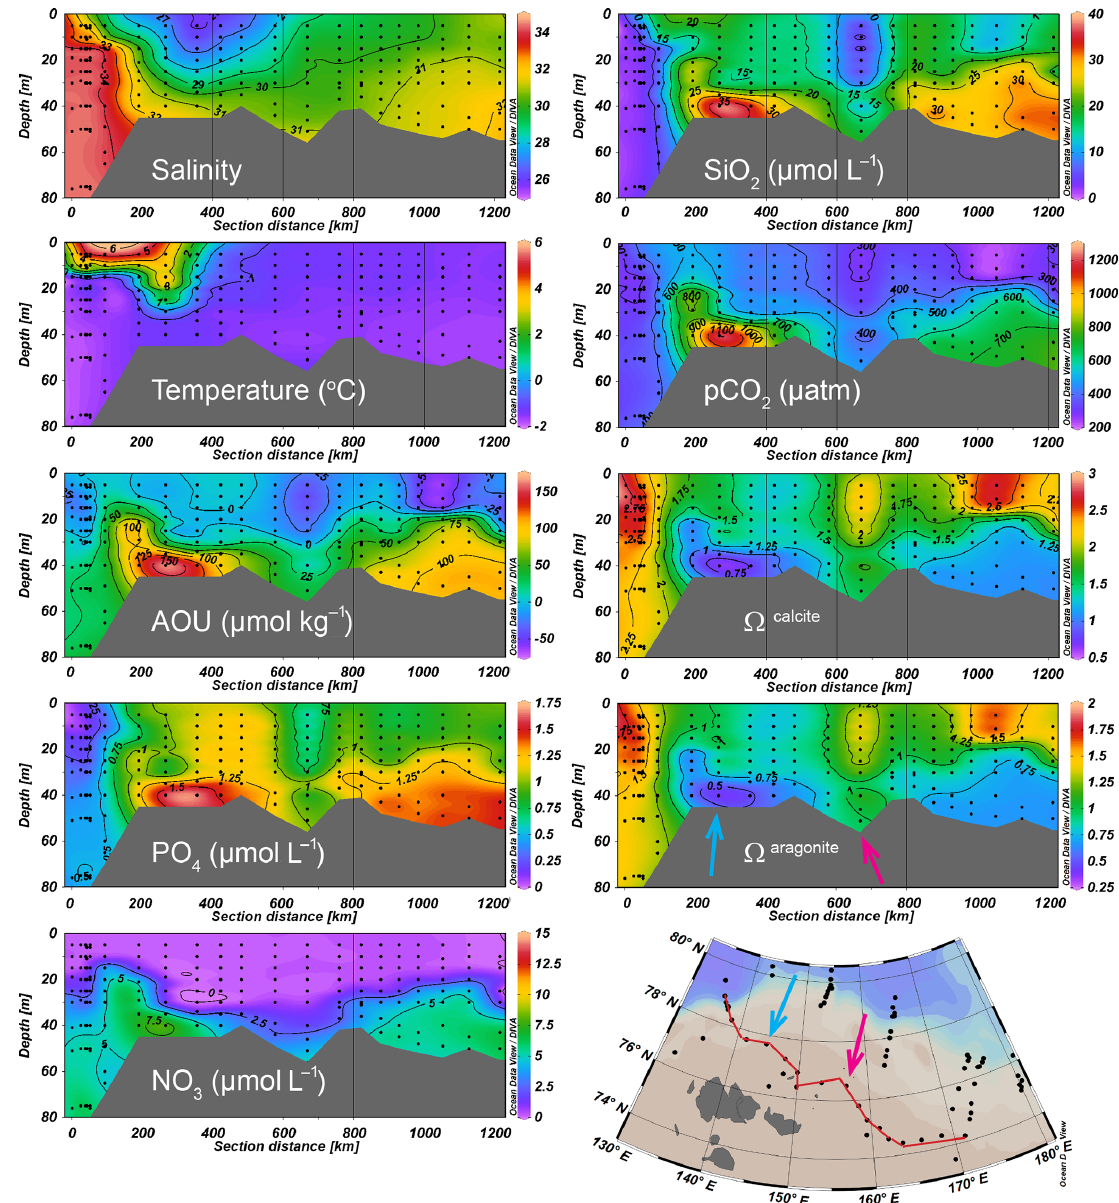
Figure 2. Sections along the outer East Siberian continental shelf as shown by the red line of the map. The location of the minimum in saturation state of calcium carbonate is noted by the blue arrow and the local maximum by the purple